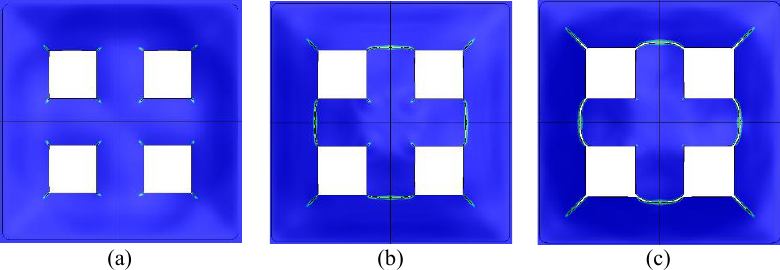
Fig. 4 . Numerical results for the blast experiments on the Docol 1400M material for a firing pressure of 15 bar in (a) and (b), and 25 bar in (c). In (a) the fitted parameters for the Docol 1400M-2 was applied, while the material parameters for Docol 1400M-1 were used in